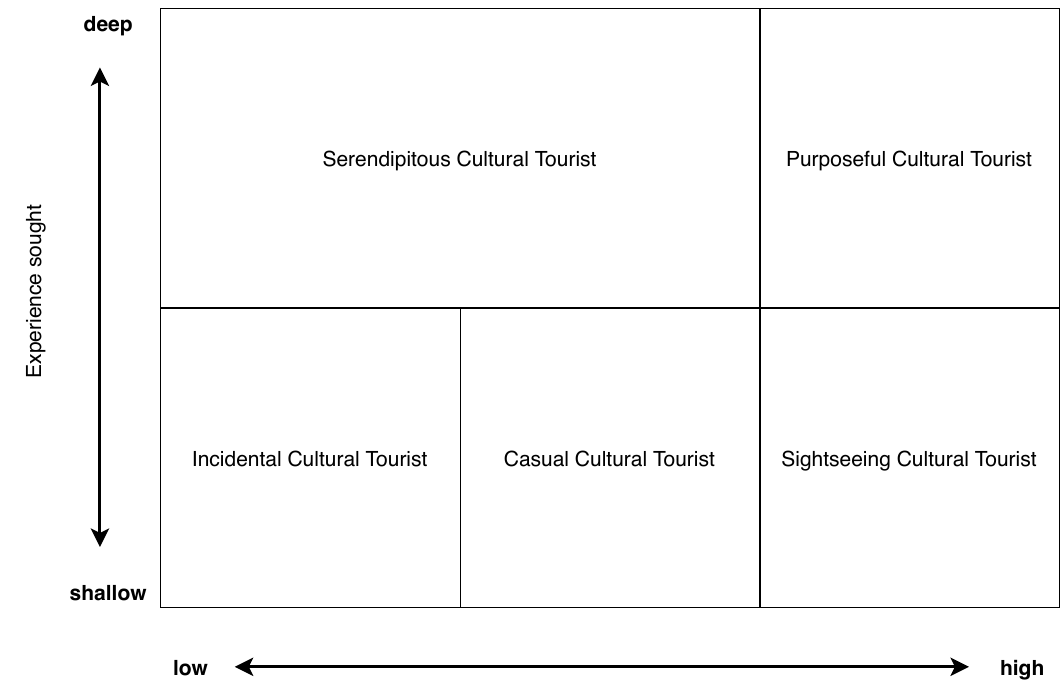
Figure 1. Cultural tourist types according to McKercher